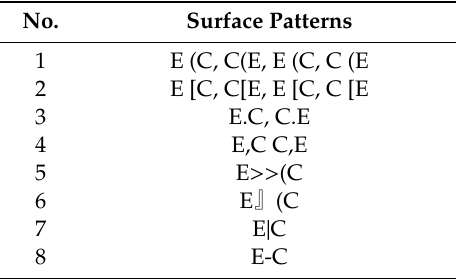
Table 1. Surface patterns obtained from the results of the search